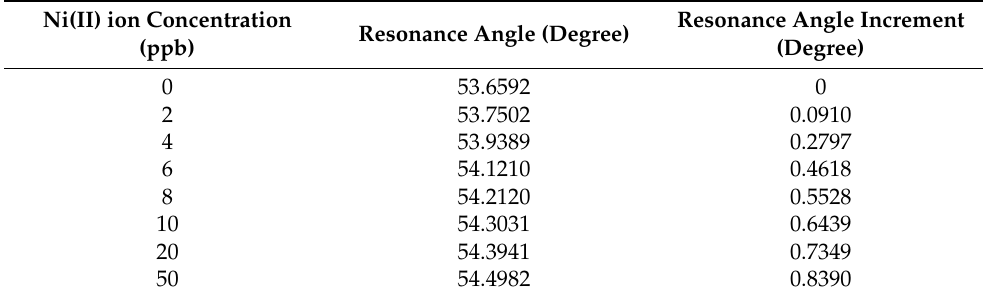
Figure 3. The SPR reflectance curves of Au/MPA/V–CNCs–CTA thin film when detecting Ni(II) ion solution ranged from 2 ppb to 50 ppb. Table 1. The increment of resonance angle for Au/MPA/V–CNCs–CTA thin film when detecting Ni(II) ion solution ranged from 2 ppb to 50